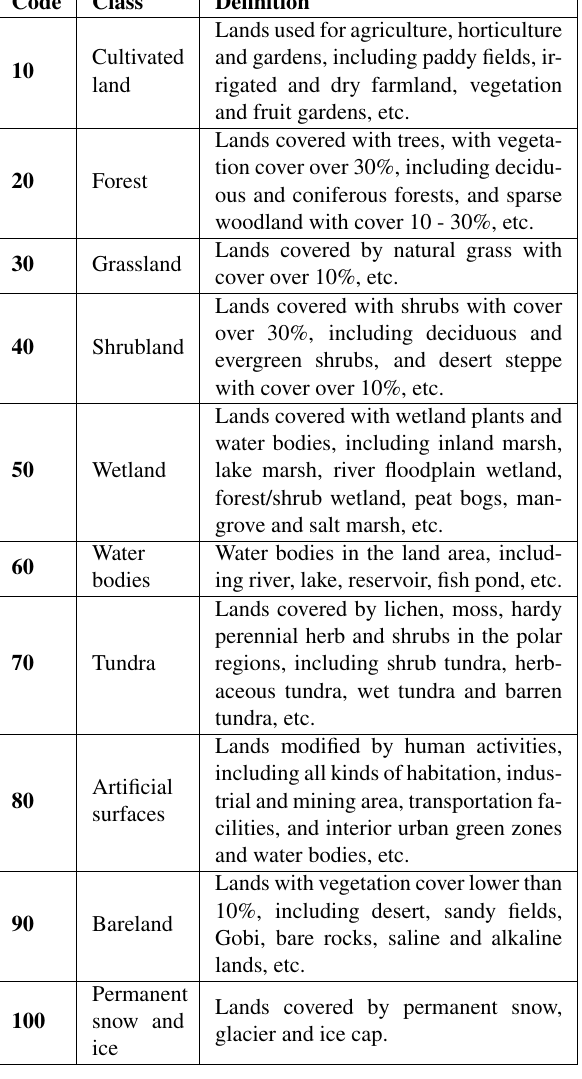
Table 2. Description of the GL30-2015 classes